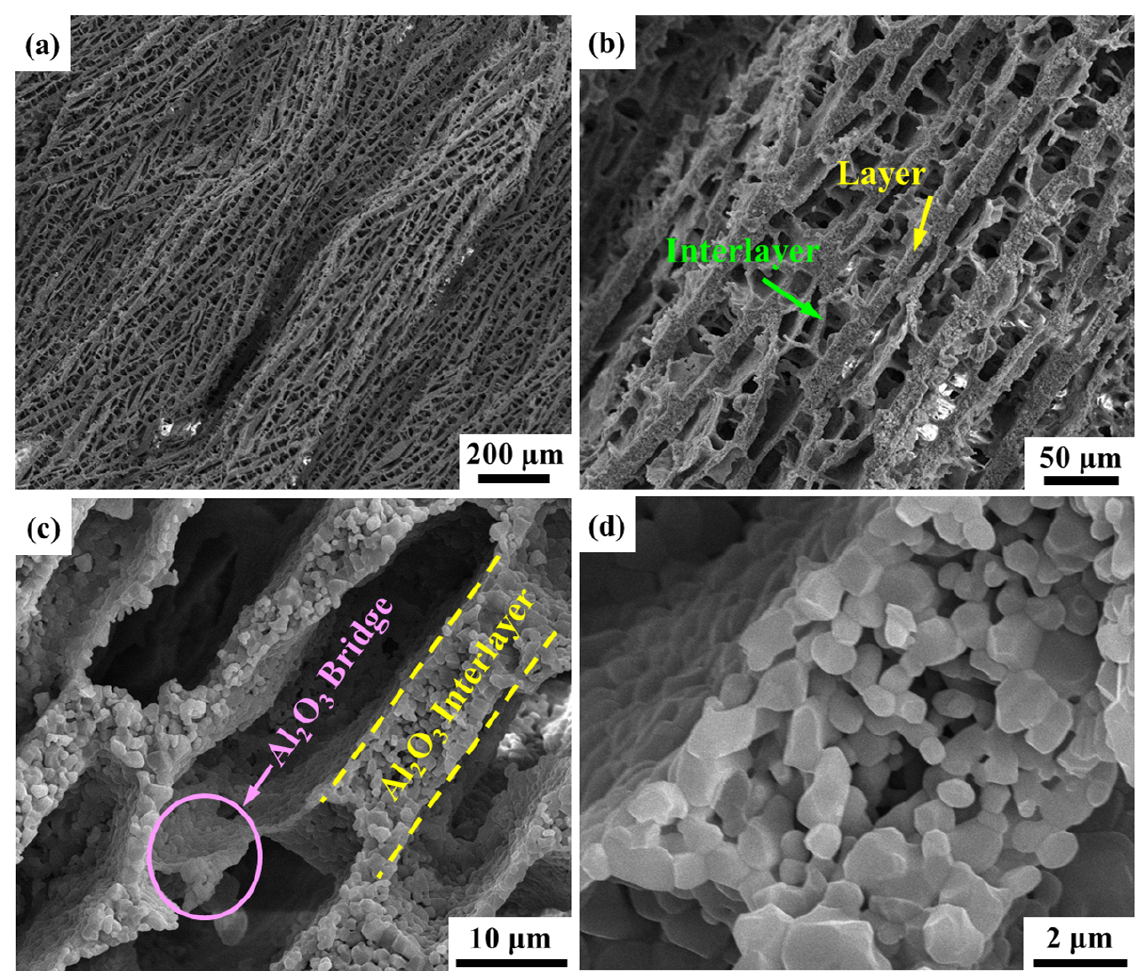
Figure 2: Representative microstructure of the porous Al 2 O 3 scaffold prepared by the freezing-dry method. (a) Low magnification image, (b) Microstructure of the layer and interlayer, (c) Microstructure of the interface and the bridges, (d) Porous microstructure in Al 2 O 3 interlayer.